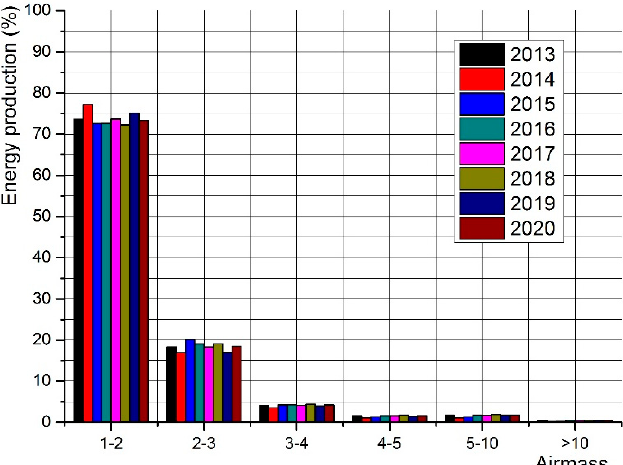
Figure 2. Percentage of electricity production in the six airmass classes defined, during the 8-year period.